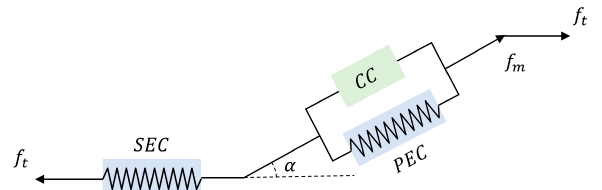
Figure 2. The diagram of the Hill-based muscle model, which is composed of the CC, PEC, and SEC [19], where 𝑓 (cid:3047) and 𝑓 (cid:3040) are the muscle tendon force and muscle fi ber force, and 𝛼 is the pennation angle, which is the angle between the direction of muscle fi bers and the direction of muscle behav-